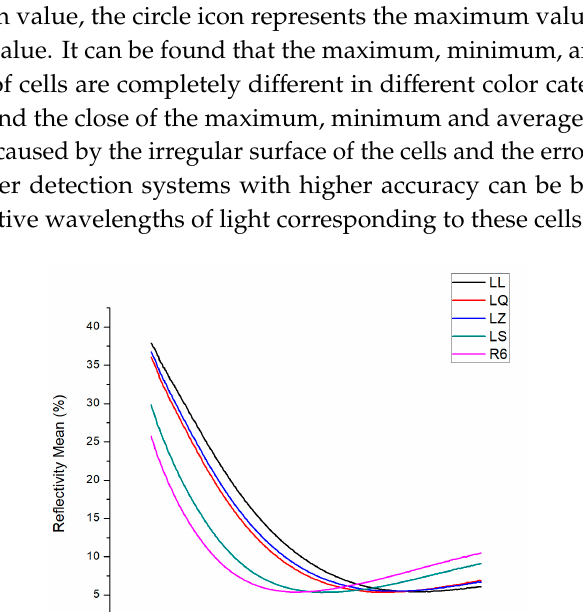
Figure 2. The reflection spectra of Polycrystalline silicon cells of different color categories, from ( a ) to ( e ) correspond to LL, LQ, LZ, LS, R6.